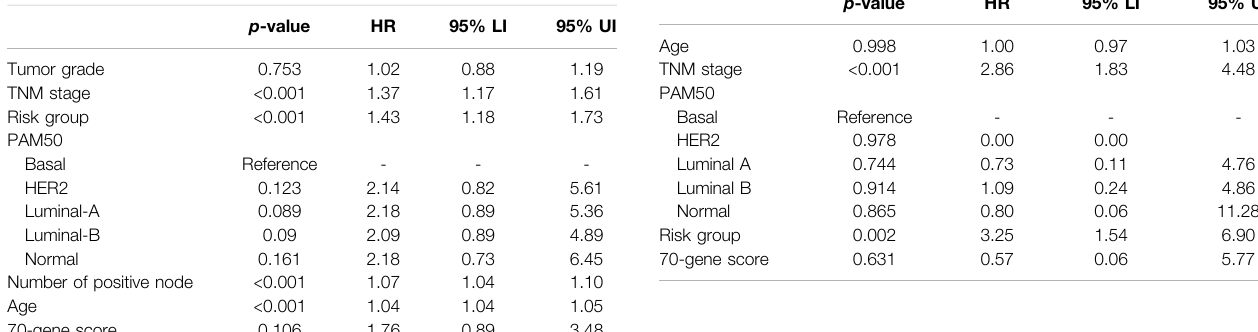
TABLE 1 | Multivariate Cox analysis of prognostic factors in the METABRIC cohort.